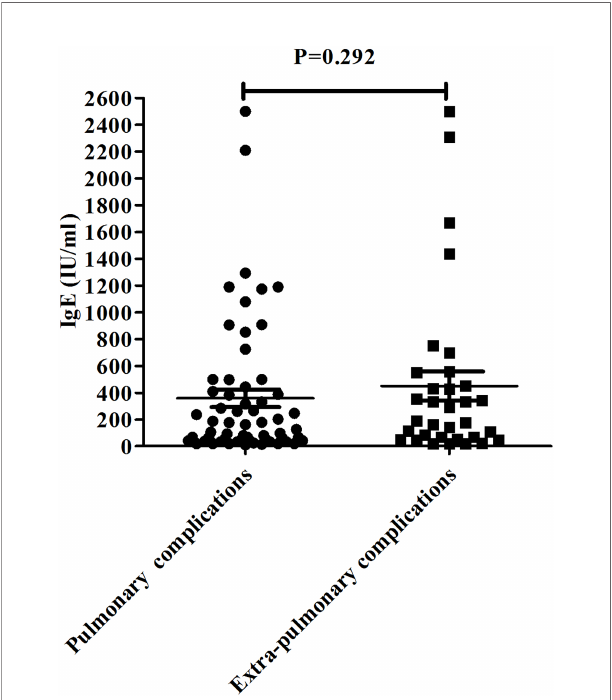
FIGURE 1 | The IgE level in the pulmonary complication group and extrapulmonary complication group.